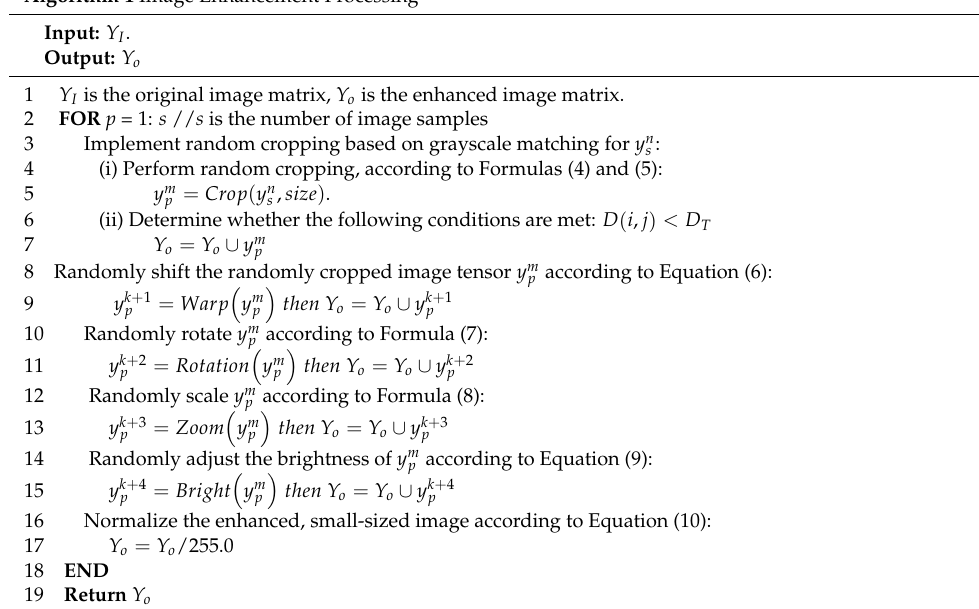
Algorithm 1 Image Enhancement